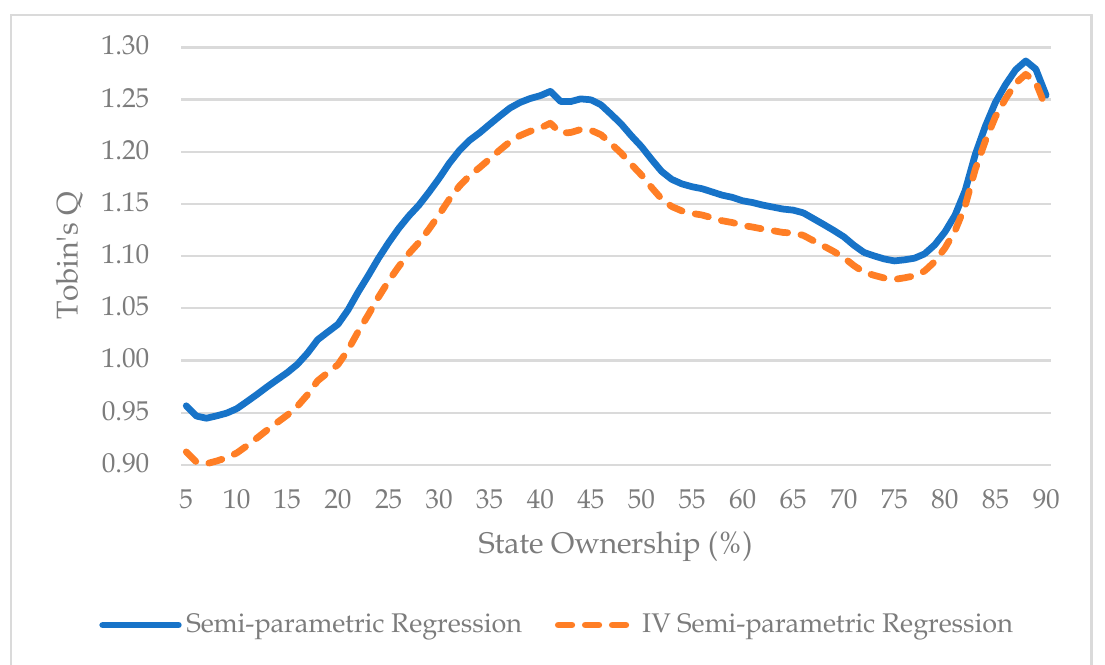
Figure A4. The marginal effect of state ownership (%) on partially privatized firm’s Tobin’s Q according to both semiparametric regression model and IV semiparametric regression model.